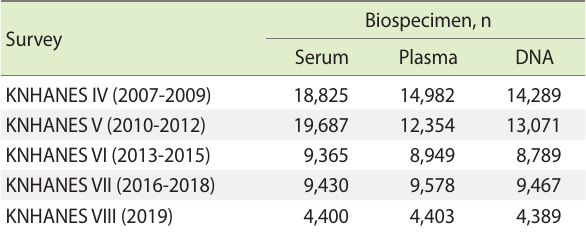
Table 5. Biospecimens of Korea National Health and Nutrition Ex- amination Survey (KNHANES)